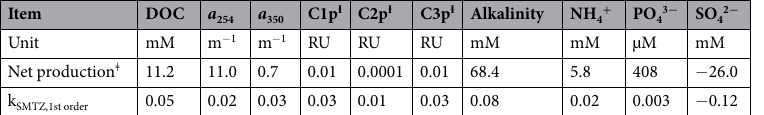
Table 1. Net production ( + ) and reduction ( − ) and kinetics rates (unit: Kyr − 1 ) of PWDOM and pore water